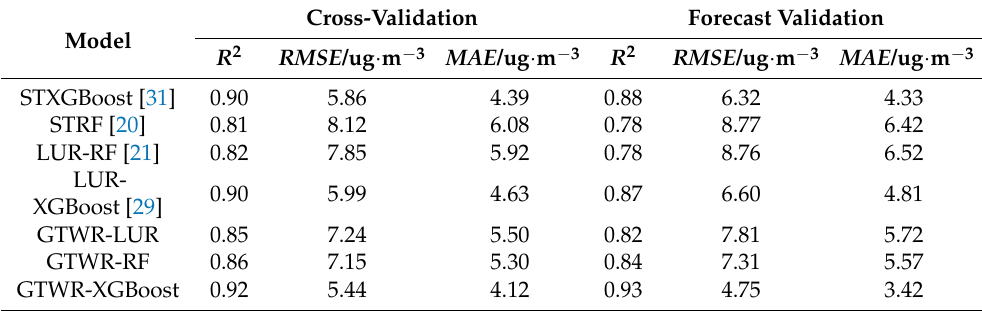
Table 5. This model is compared with recent research models.